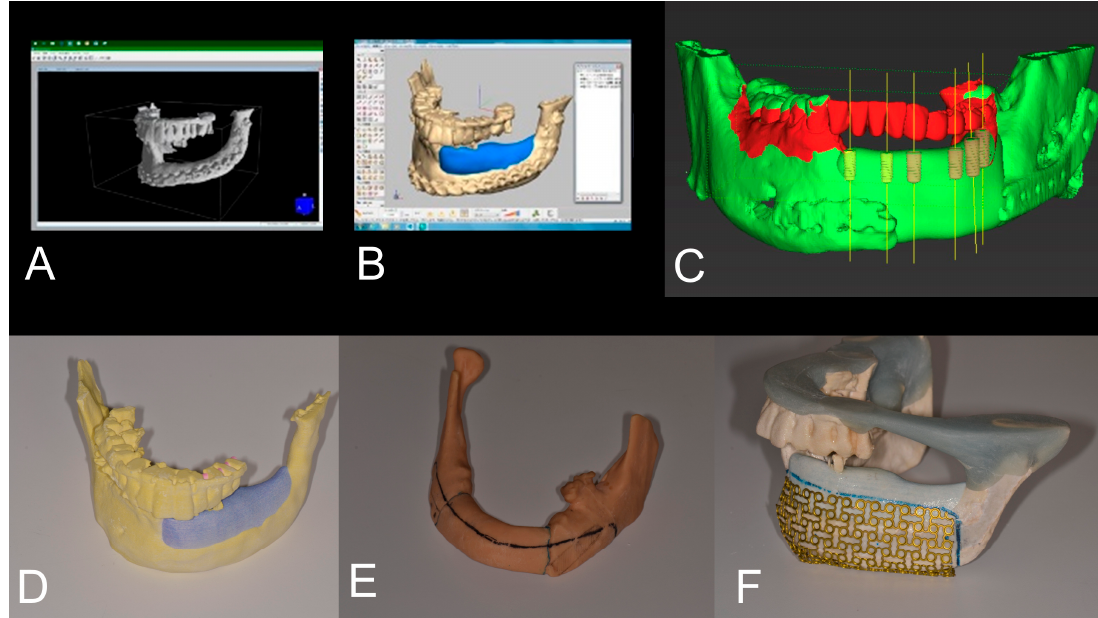
Figure 1. The procedures of virtual mandibular reconstruction with CT data. The first step consisted of obtaining the DICOM files from CT data. The 2D CT images were reconstructed into 3D CT images with the use of Volume Extractor ® software ( A ). After this process, the software was used to transform them into a digital 3D object file (Standard Tessellation Language (STL)). The STL file was imported into Geomagic Freeform Software ( B ). In some cases, dental implant simulation was also performed simultaneously ( C ). After the virtual simulation, a mandibular 3D model was produced. The photograph shows a plaster-based 3D model ( D ) and an acrylic resin-based 3D model ( E ). Then, the titanium mesh was pre-bended on the model ( F ).